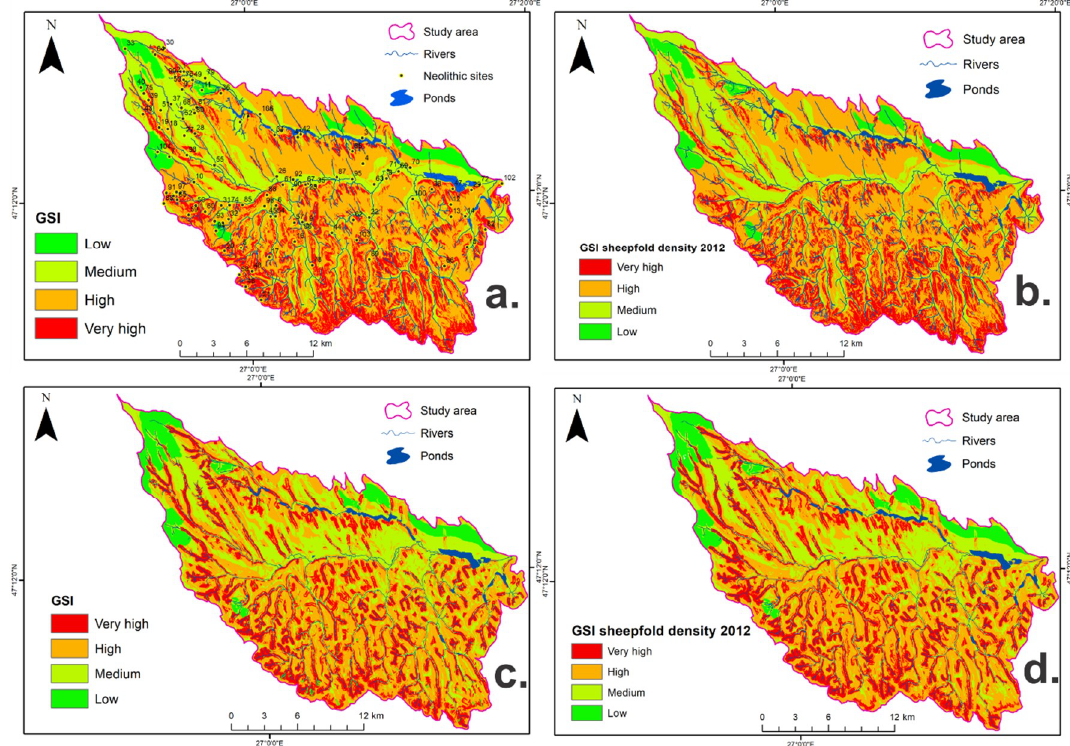
Figure 5. Gully susceptibility index produced using ( a ) frequency ratio (FR) method, ( b ) FR method including sheepfold density as a contributing factor, ( c ) information value (IV) method, and ( d ) IV method including sheepfold density as a contributing factor.